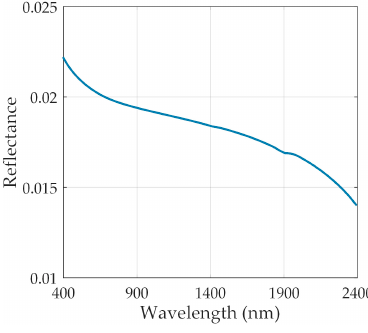
Figure 1. Spectral reflectance of pure water [42] .